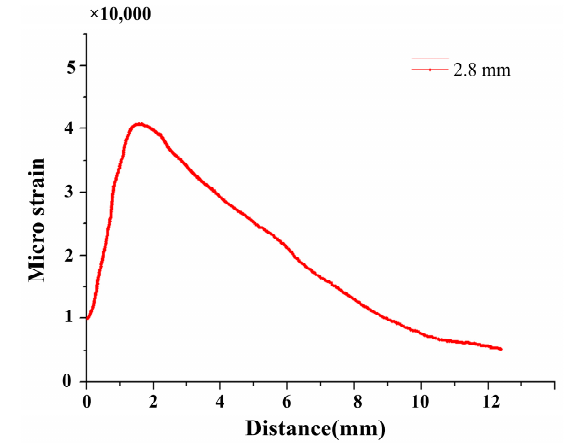
Figure 6. Finite element analysis of a crack with a length of 2.8 mm.